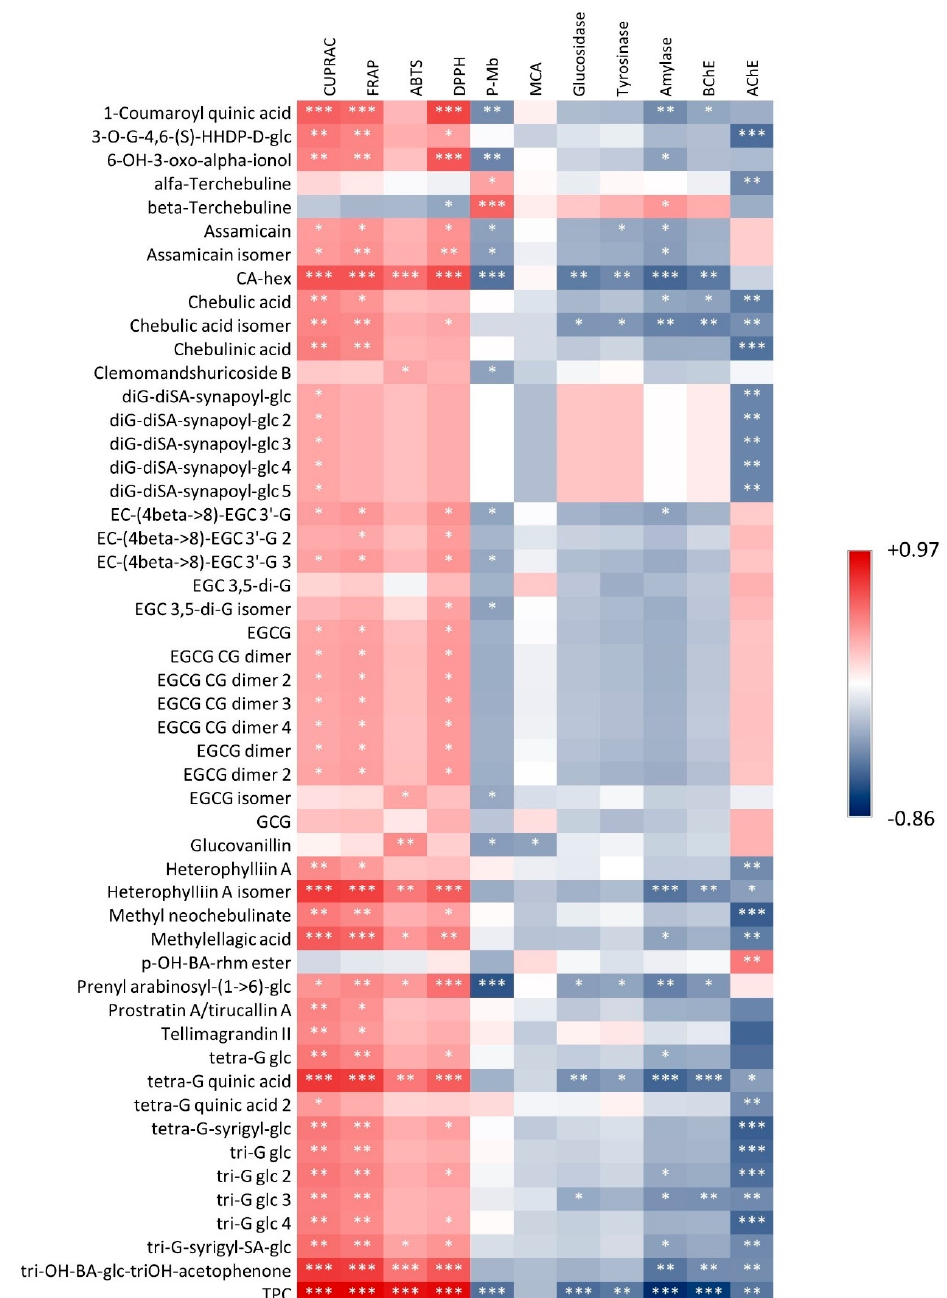
Figure 2. Correlation heatmap showing positive (red colour) and negative (blue colour) correlations between specific polyphenols and measured bioactivities. Color scale is dependent on Pearson’s r value. Significance levels are indicated by asterisks in the plot. *: p < 0.05; **: p < 0.01; ***: p < 0.001. Furthermore, the OPLS model was generated using the data from the chemical anal- ysis and combining the results of the bioassays. Figure 3 shows the score scatter plot, while the loading plot is shown in Figure 4.